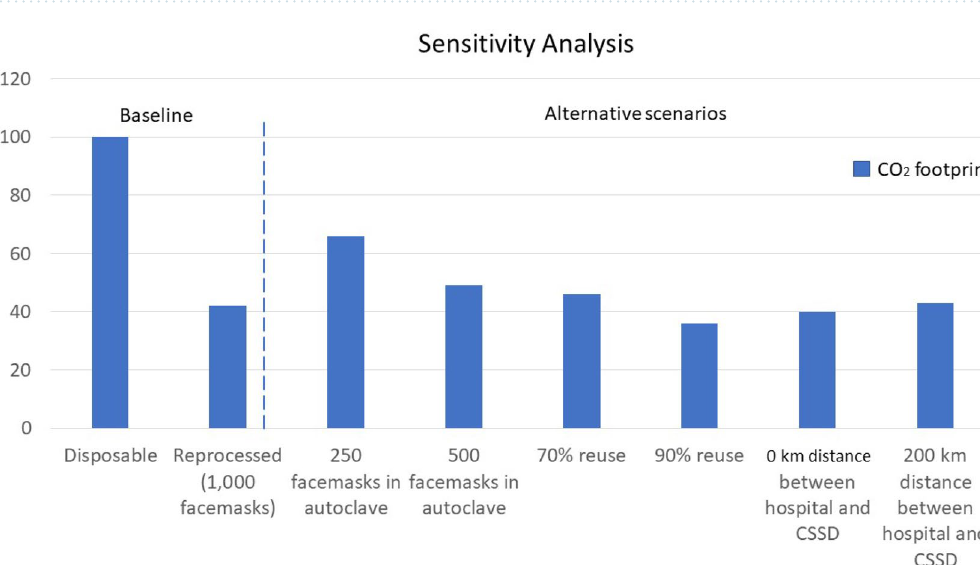
Figure 3. Sensitivity analysis. Left of dotted line, baseline disposable (masks used only one time) versus reprocessed face masks with benchmark autoclave loading capacity of 1000 masks, rejection rate of 20% and transport distance of 46.1 km. Right of dotted line, effect on carbon footprint of different autoclave loading capacity, different rejection rates and different transport distances from hospital to sterilisation